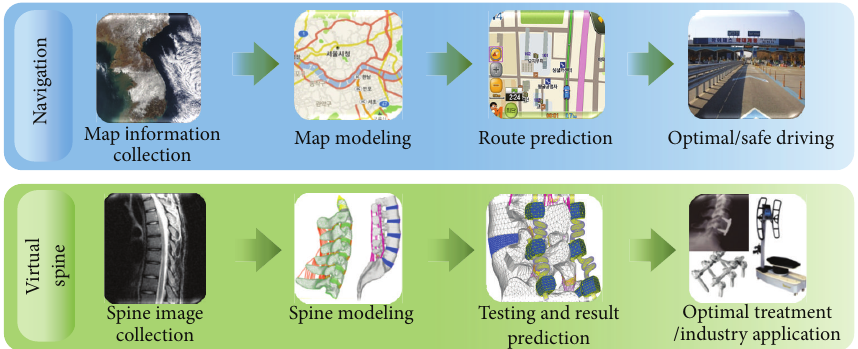
Figure 2: Comparison between a vehicle’s navigation system and e -Spine.